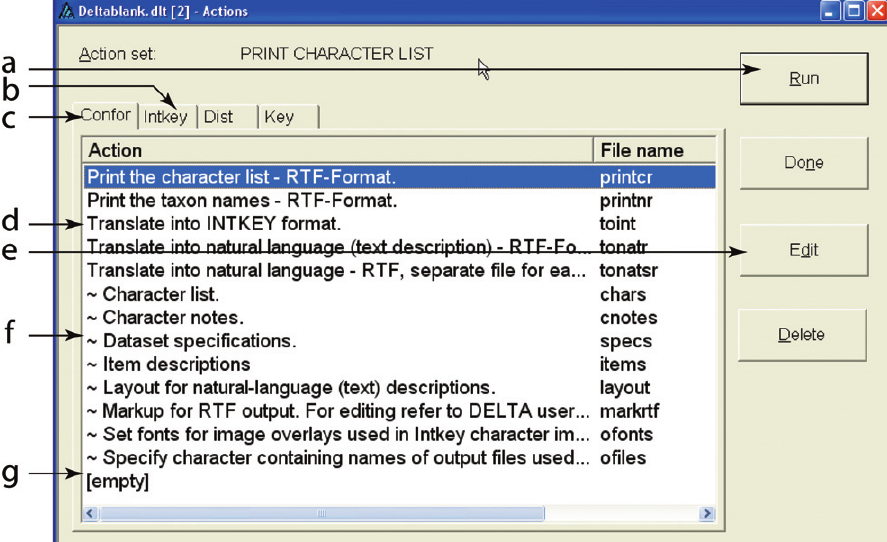
Figure 22a–g. Th e Confor dialog tab in Action